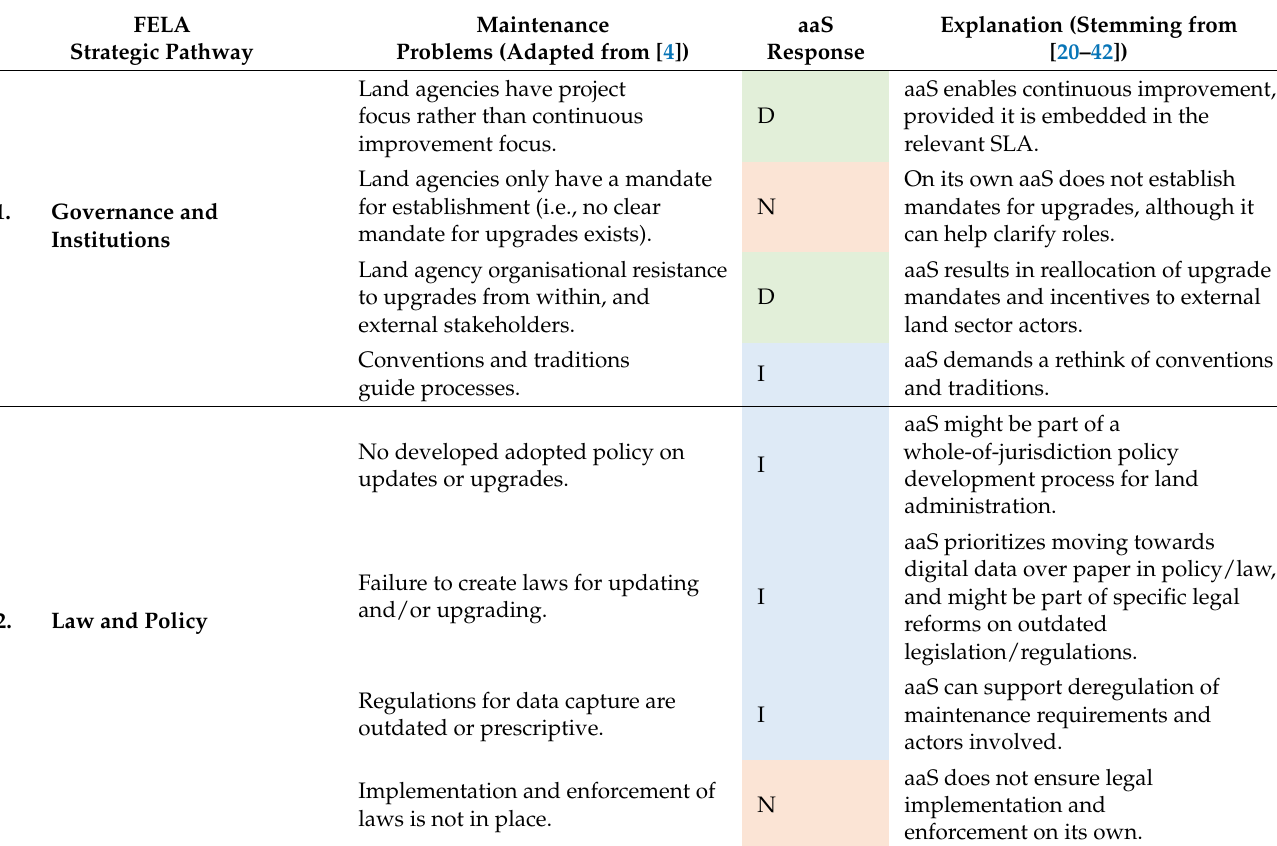
Table 1. Overview of land administration maintenance challenges and potential responses of aaS